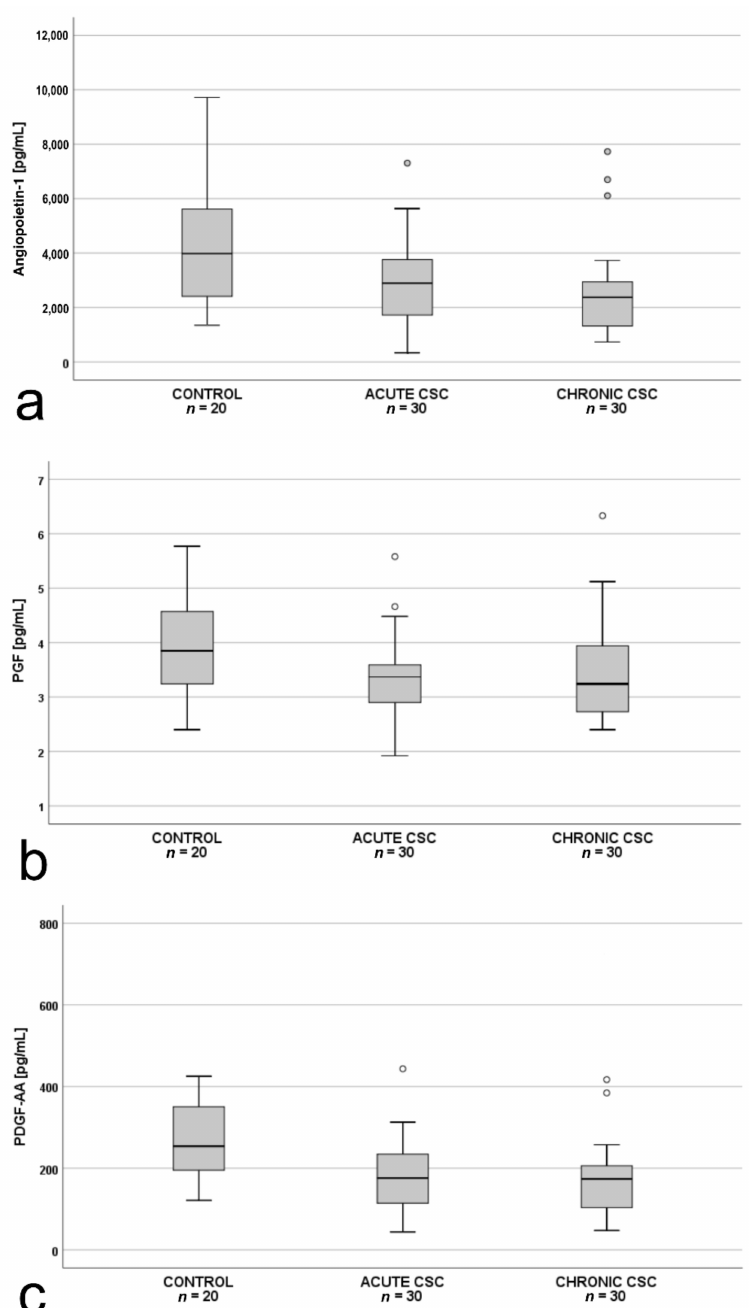
Figure 1. Box-and-whisker plot of: ( a ) plasma angiopoietin-1 ( p = 0.01; X 2 (2) = 9.656); ( b ) placental growth factor (PlGF; p = 0.045; F(2.77) = 3.230); and ( c ) plasma pigment epithelium–derived factor (PDGF-AA; p = 0.03; F(2.77) = 3.558) levels in patients with acute central serous chorioretinopathy, patients with chronic central serous chorioretinopathy and controls. The line inside the box represents the median; the lower and upper sides of the box represent the lower and upper quartiles, respectively. Whiskers represent cases distant up to 1.5 of interquartile range (IQR) from the respective quartile; circles, cases distant from 1.5 to 3 IQRs. p values were estimated using the analysis of variance for normally distributed variables and the Kruskal–Wallis test